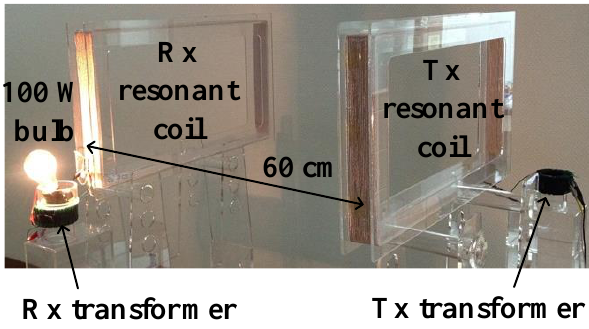
Figure 10. Photograph of a 100-watt light bulb.